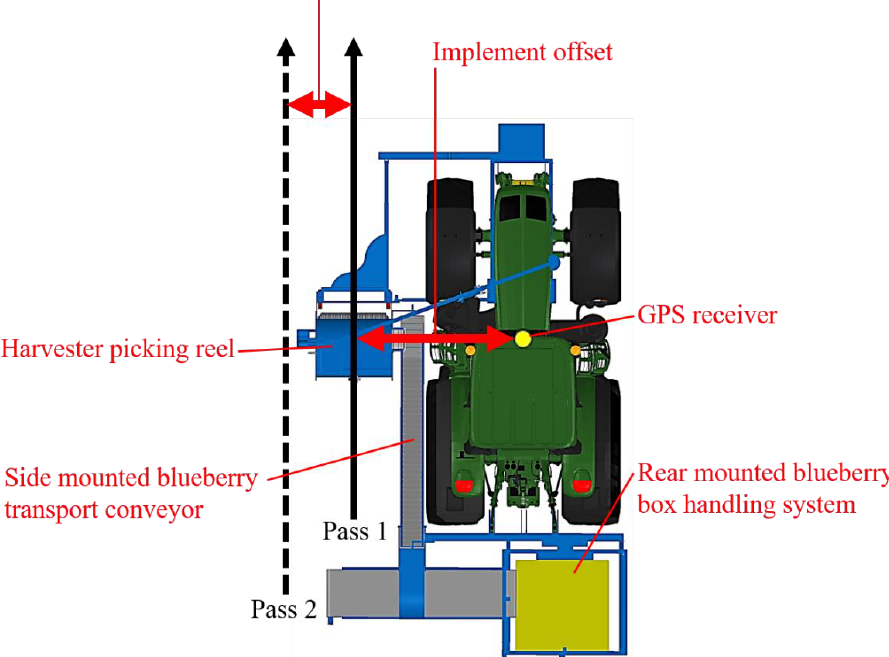
Figure 4. Schematic showing the positioning of the Global Navigation Satellite Signal (GNSS) receiver, implement offset, and desired track spacing for the wild blueberry harvester.